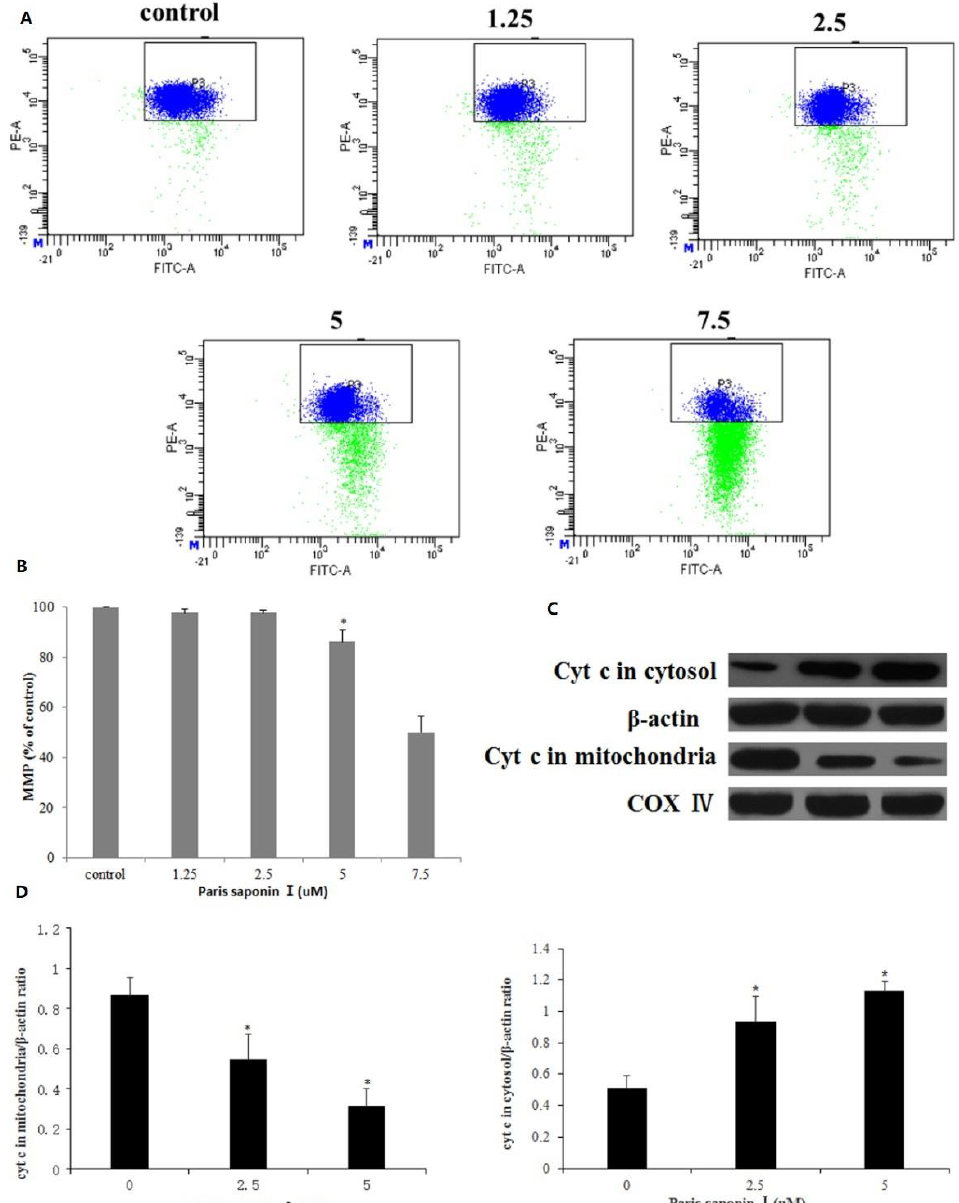
Figure 7. Effects of PSI on mitochondrial membrane potential (MMP) and the release of cytochrome c in HepaRG cells . ( A ) MMP was determined flow cytometrically. ( B ) The percentage of MMP in HepaRG cells. Data are presented as mean ± SD. * p < 0.05, compared with the control group. ( C ) The content of cytochrome c in mitochondria and cytoplasm, as determined using Western blot. Cytochrome c oxidase subunit 4 (COX IV) and β-Actin served as internal controls for the mitochondrial fraction and cytosolic fractions, respectively. ( D ) Optical density quantification results. Data are presented as mean ± SD. * p < 0.05 compared with the vehicle-treated group.